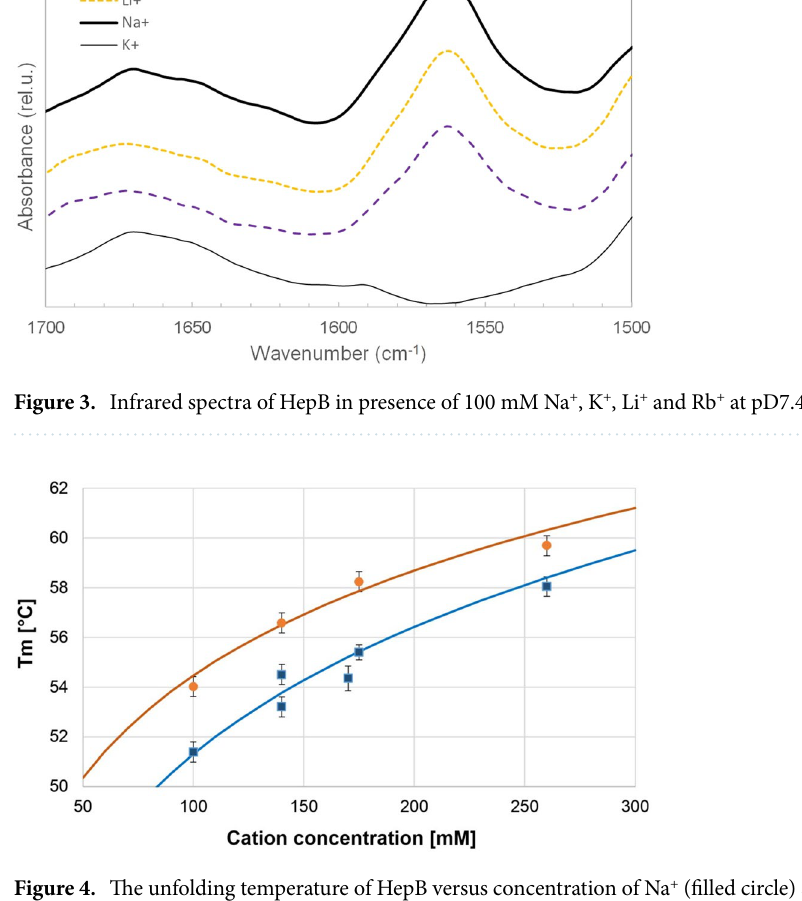
Figure 4. The unfolding temperature of HepB versus concentration of Na + (filled circle) and K + (filled square) ions. The fitted curves corresponding to the Eq. (10) are also